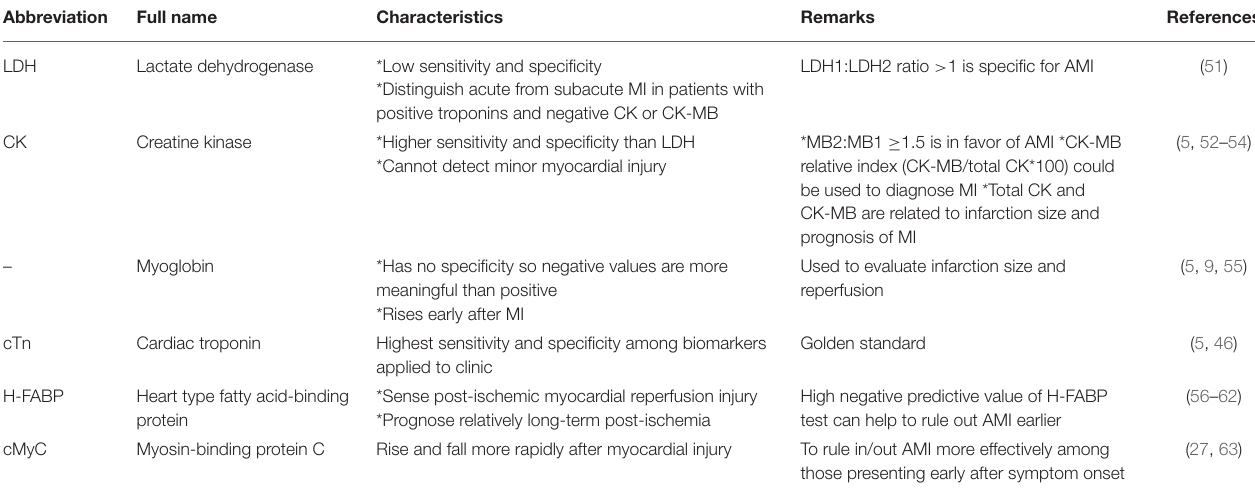
TABLE 2 | Biomarkers originated from myocardial tissue.